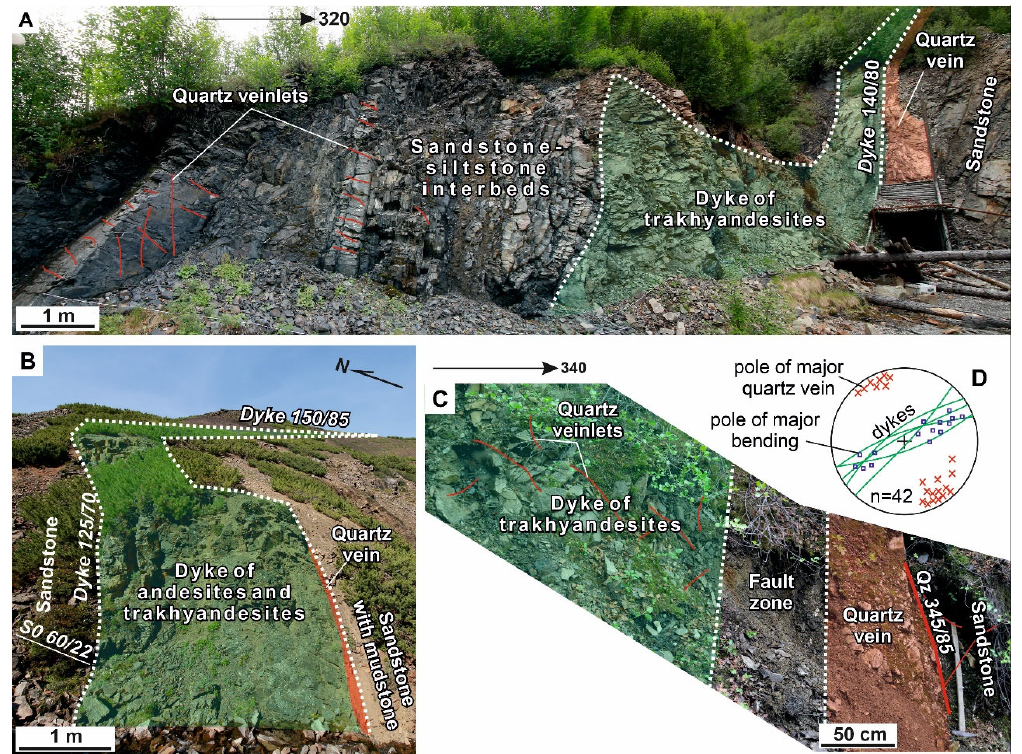
Figure 5. Photographs of the ore bodies in the intrusion-hosted OGDs, central YKMB: ( A , C ) V’yun; ( B ) Shumnyi; ( D ) stereogram of the veins, bedding, and dykes. Abbreviations: S0—bedding, Qz— quartz vein, D—dyke. Structural data were plotted on the upper hemisphere of the Wulff stereo- graphic net.